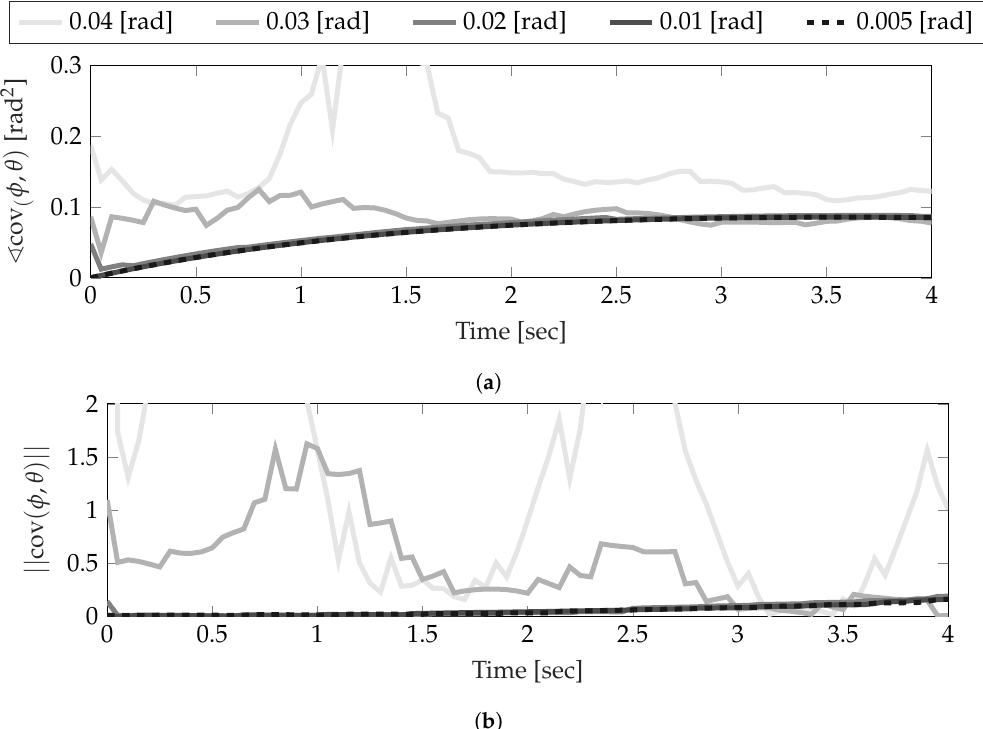
Figure 5. Effects of integration variable on estimated covariance relative error. Each line represents a different elemental angle ranging from 0.04 to 0.005 rad. ( a ) Angle Component. ( b ) Length